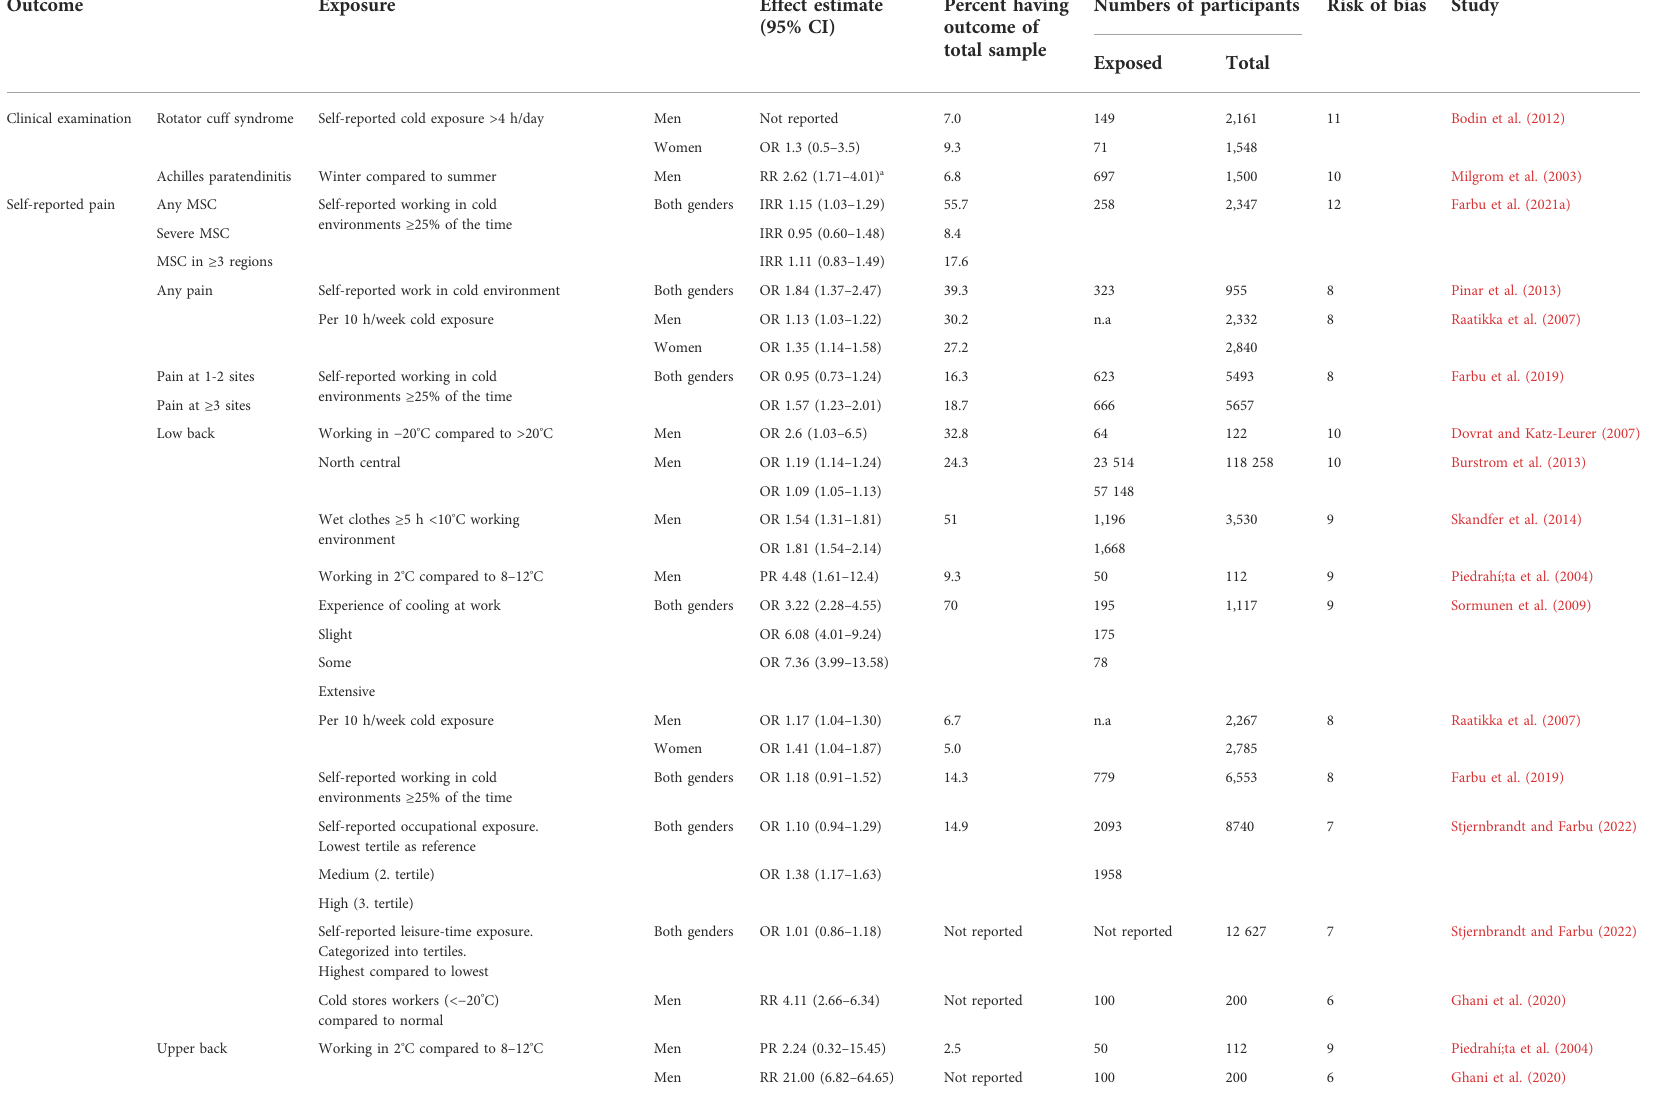
TABLE 3 Effect estimates sorted after type and type of assessment of pain or regional pain. Outcome